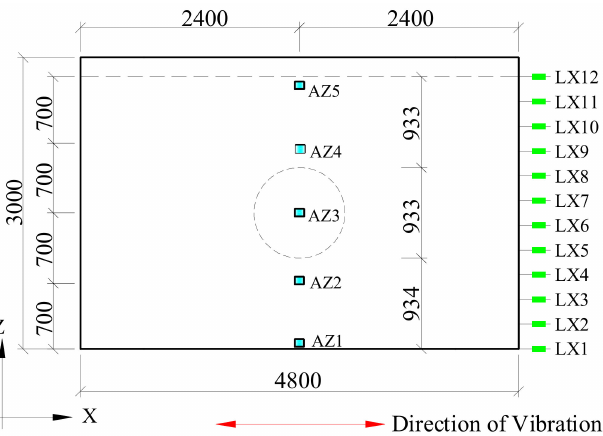
Figure 7. Cross-sectional layout of sensors for the FF model (unit: